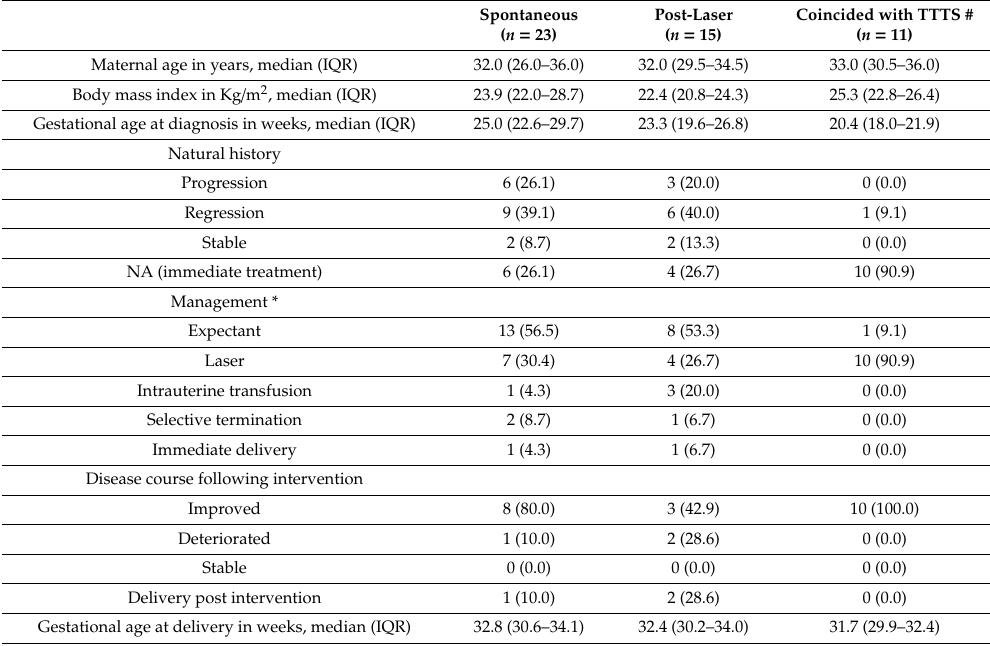
Table 3. Diagnostic accuracy of traditional, delta PSV > 0.5 MoM, and Delphi consensus criteria, according to postnatal hemoglobin *.